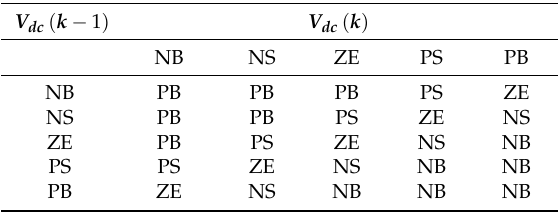
Table 2. Fuzzy rule base for the proposed algorithm with IED